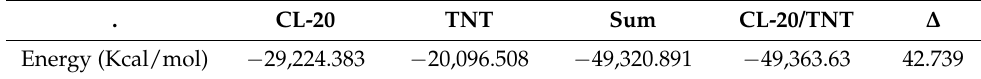
Table 2. Energy comparison of CL-20, TNT and CL-20/TNT crystals.